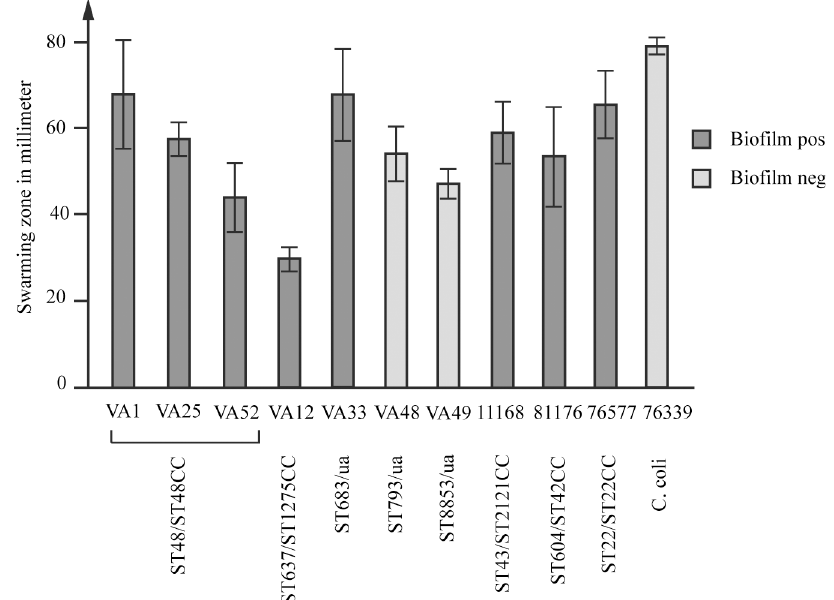
Fig 1. Motility and biofilm formation of the C . jejuni water isolates. Motility shown as swarming diameters in soft agar plates. Mean values of 3 experiments with error bars indicatingSDs are shown. Biofilm positive isolates shown in dark grey and negative isolates in light grey. The C . jejuni strain 76577 was includedas a positive control for biofilm formation. The C . jejuni strains NCTC 11168 and 81–176and the C . coli strain 76339 were includedfor comparison. ST types and CCs are shown where available(ua = unassigned).